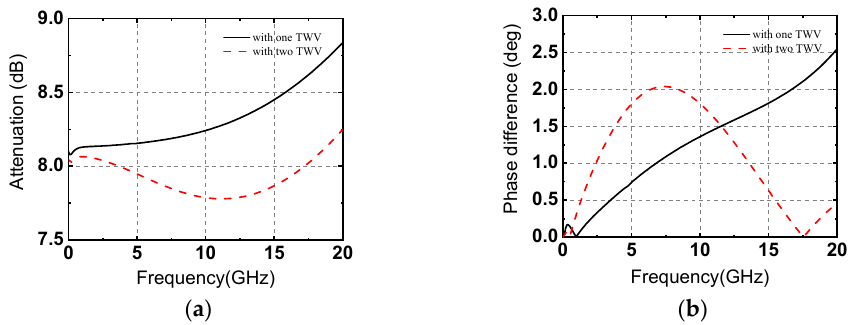
Figure 4. ( a ) The attenuation and ( b ) phase difference of the 8-dB cells with one and two TWVs.